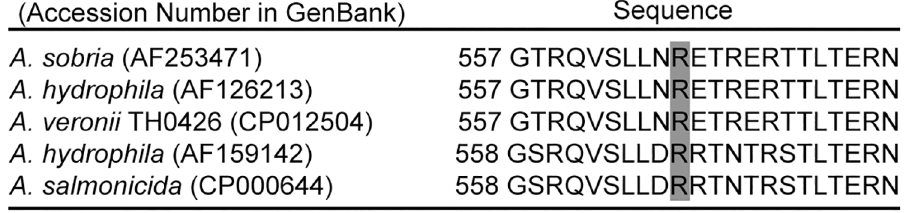
Fig 5. Sequence alignment around the position of 566 of severalASPs. The sequencesshown are quotedfrom GenBank. The accessionnumbers of each sequencein GenBank are shown in the figure. The numbers at the left edge of the sequenceindicatethe position from the amino terminalend of each ASP. Arginineresiduescorrespondingto Arg-566of ASP of A . sobria 288 are indicatedby shadowedcharacters.